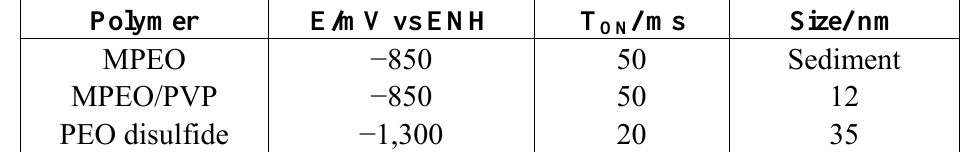
Table 2. Summary of experimental conditions in gold nanoparticles synthesis. Adapted from Ref.